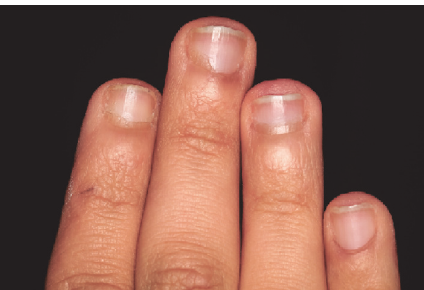
Figure 9: Retrieval of a normal appearance of the fingertips after one month of treatment.